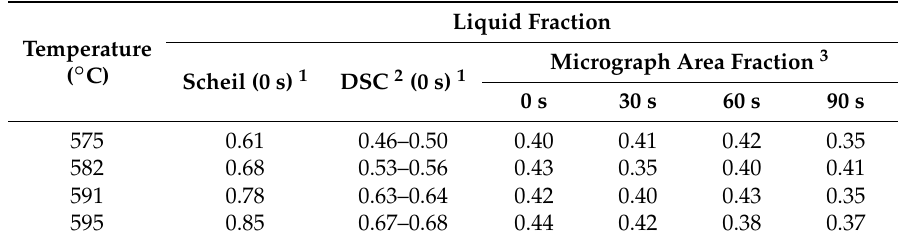
Table 4. Liquid fraction of B319+Fe alloy samples heat-treated for 0–90 s at four temperatures and subsequently water quenched.